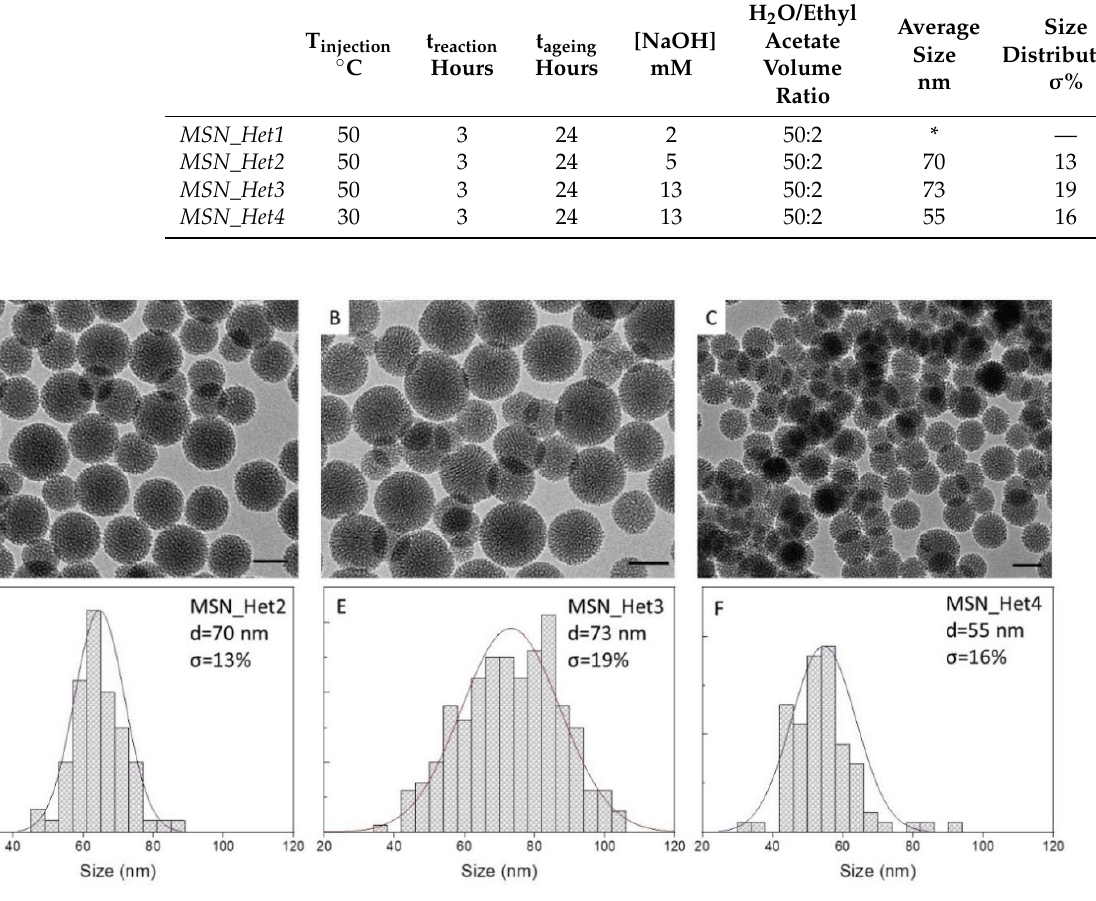
Figure 4. TEM micrographs ( A – C , scale bar 50 nm) and the corresponding size distribution statistical analysis ( D – F ) of MSNs prepared by injecting TEOS 4.47 mmol (1 mL) at T injection = 50 °C (( A , B , D , E ) MSN_Het2 and MSN_Het3 samples) or T injecttion = 30 °C (( C , F ) MSN_Het4 sample) to 50 mL of H 2 O/Ethyl acetate (50:2 v / v ), [CTAB] = 5 mM and [NaOH] 5 mM